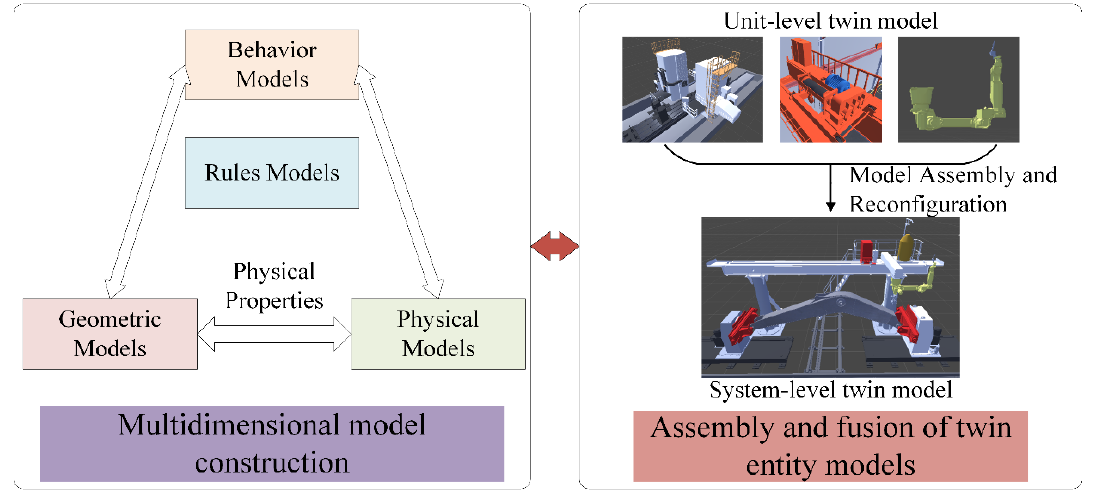
Figure 4. Block diagram of multidimensional model construction.